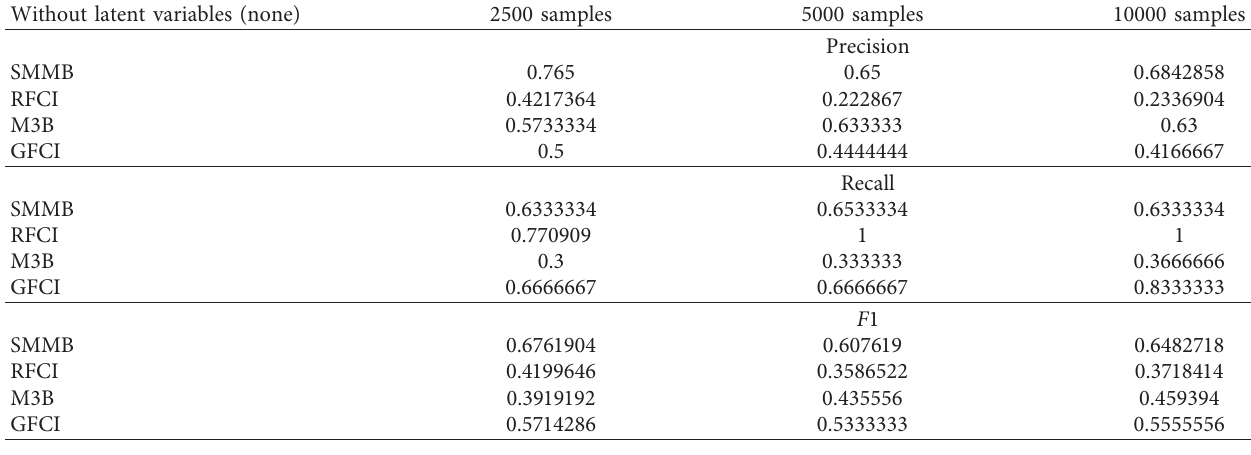
Table 1: When there is no latent variable, SMMB algorithm compares with RFCI, M3B, and GFCI algorithms in accuracy, recall rate, and F 1 value.